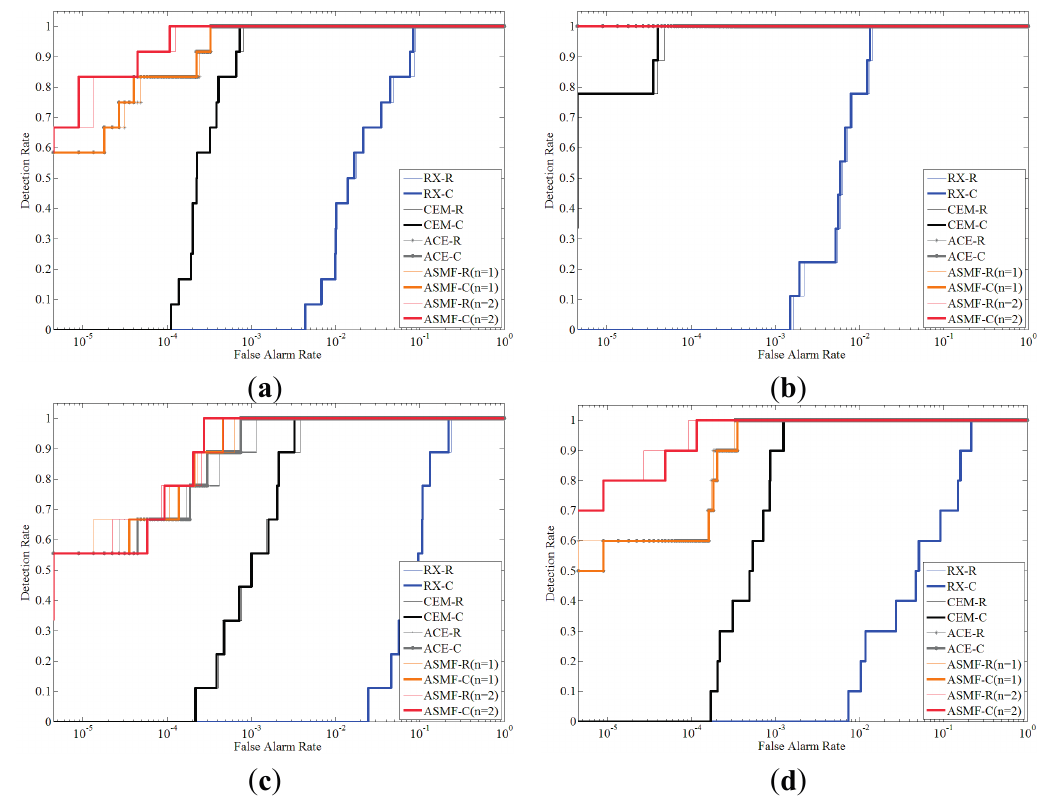
Figure 19. ROC curves of the HyMap real hyperspectral datasets according to the correlation-based and covariance-based algorithms when the target is ( a ) F1, ( b ) F2, ( c ) F3, and ( d ) F4.